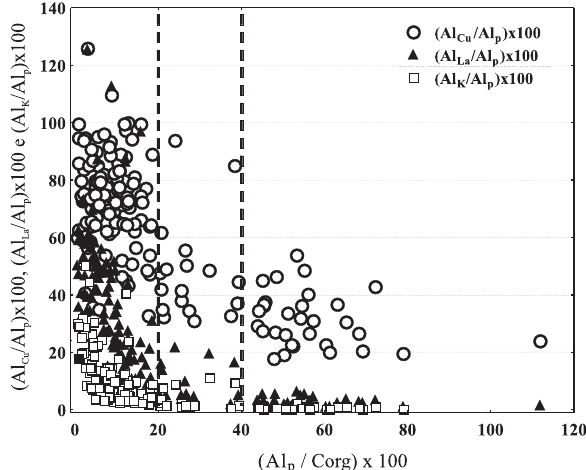
Figura 3. Relação entre a saturação por Al extraído por pirofosfato no húmus dos solos estudados ((Al /Corg) x 100) e a percentagem de Al p removido por CuCl , LaCl e KCl em relação ao 2 3 ) elemento no extrato pirofosfato ((Al /Al ) x org Cu p 100), (Al /Al ) x 100 e (Al /Al ) x 100), La p K p e carbono orgânico respectivamente). As linhas tracejadas p delimitam os valores de 20 e 40 para a saturação por Al no